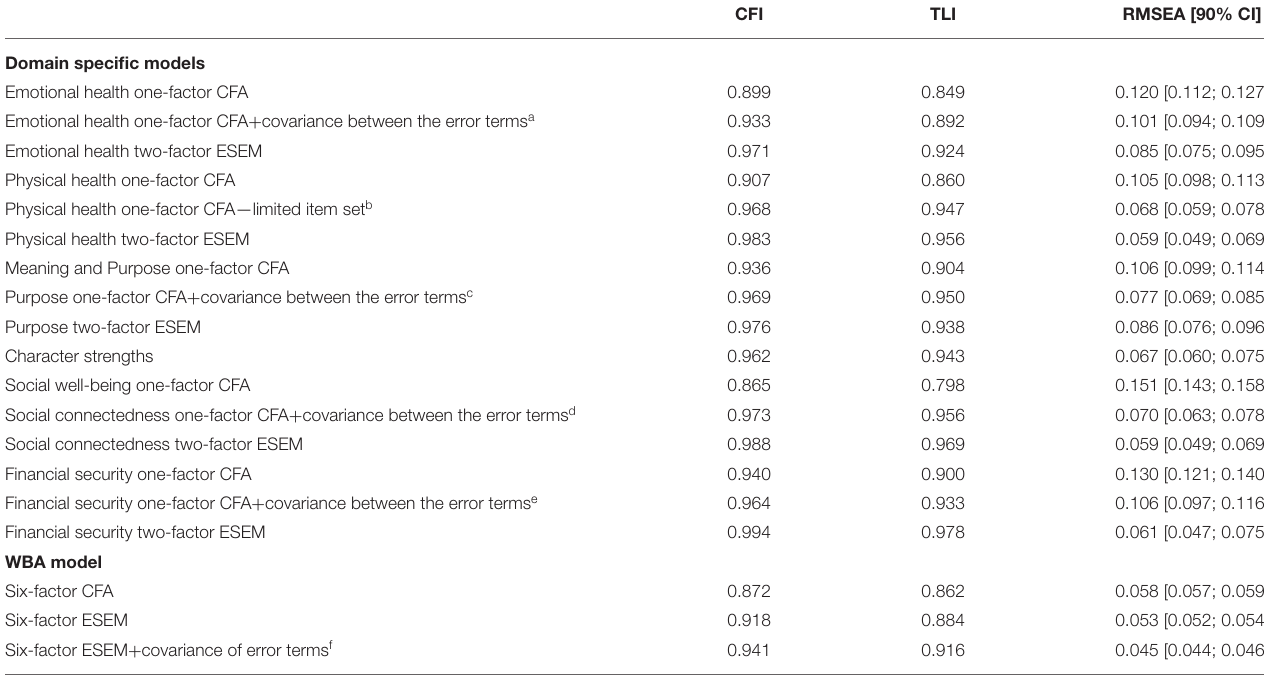
TABLE 2 | Goodness of fit for models based on the T1 and T2 stacked file ( n = 3,579).